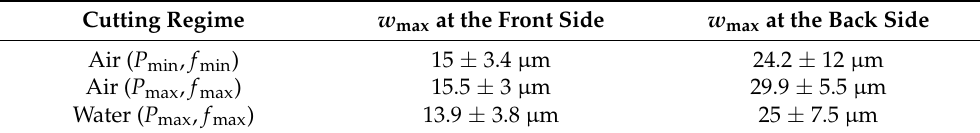
Figure 4. Optical micrographs showing cut edges at the front side of laser-cut glass strips. Rows represent different glass thicknesses, while columns represent different processing conditions. The scale bars represent 100 µm and apply to all panels in the figure. Table 3. Maximum defect widths averaged over different glass thicknesses (110, 300, and 550 µm). Cases for the front and back sides are presented separately.